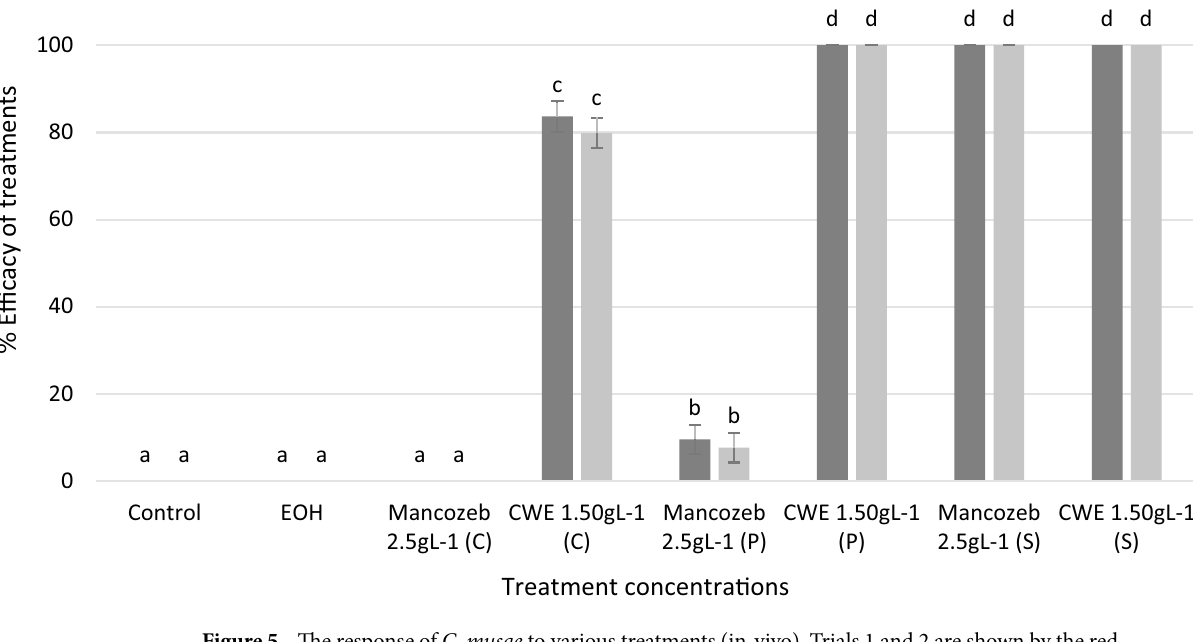
Figure 5. The response of C. musae to various treatments (in-vivo). Trials 1 and 2 are shown by the red and orange bars, respectively. According to the Tukey test results, values followed by similar letters are not